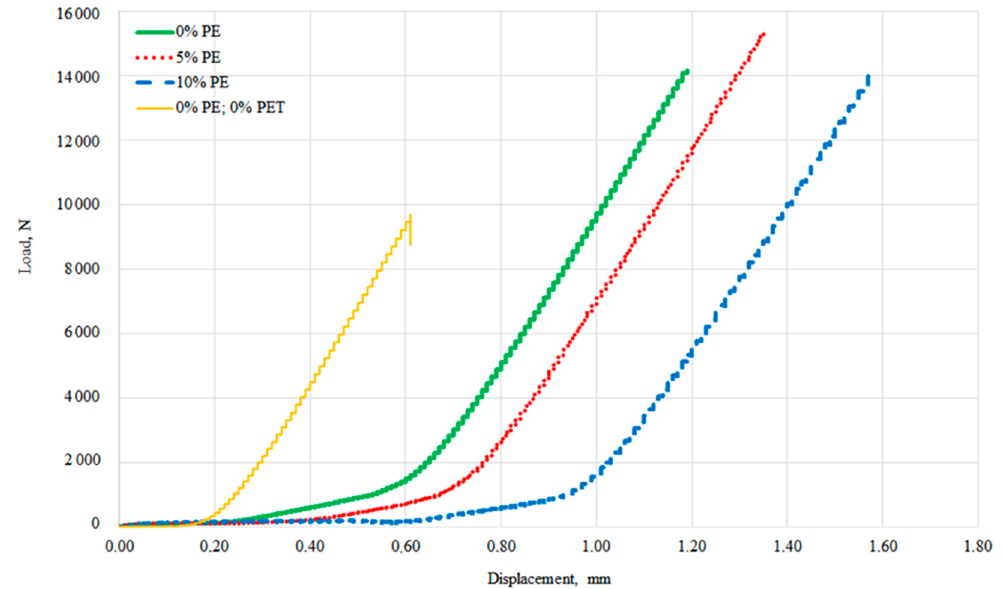
Figure 10. Load vs. displacement curves for flexural strength.